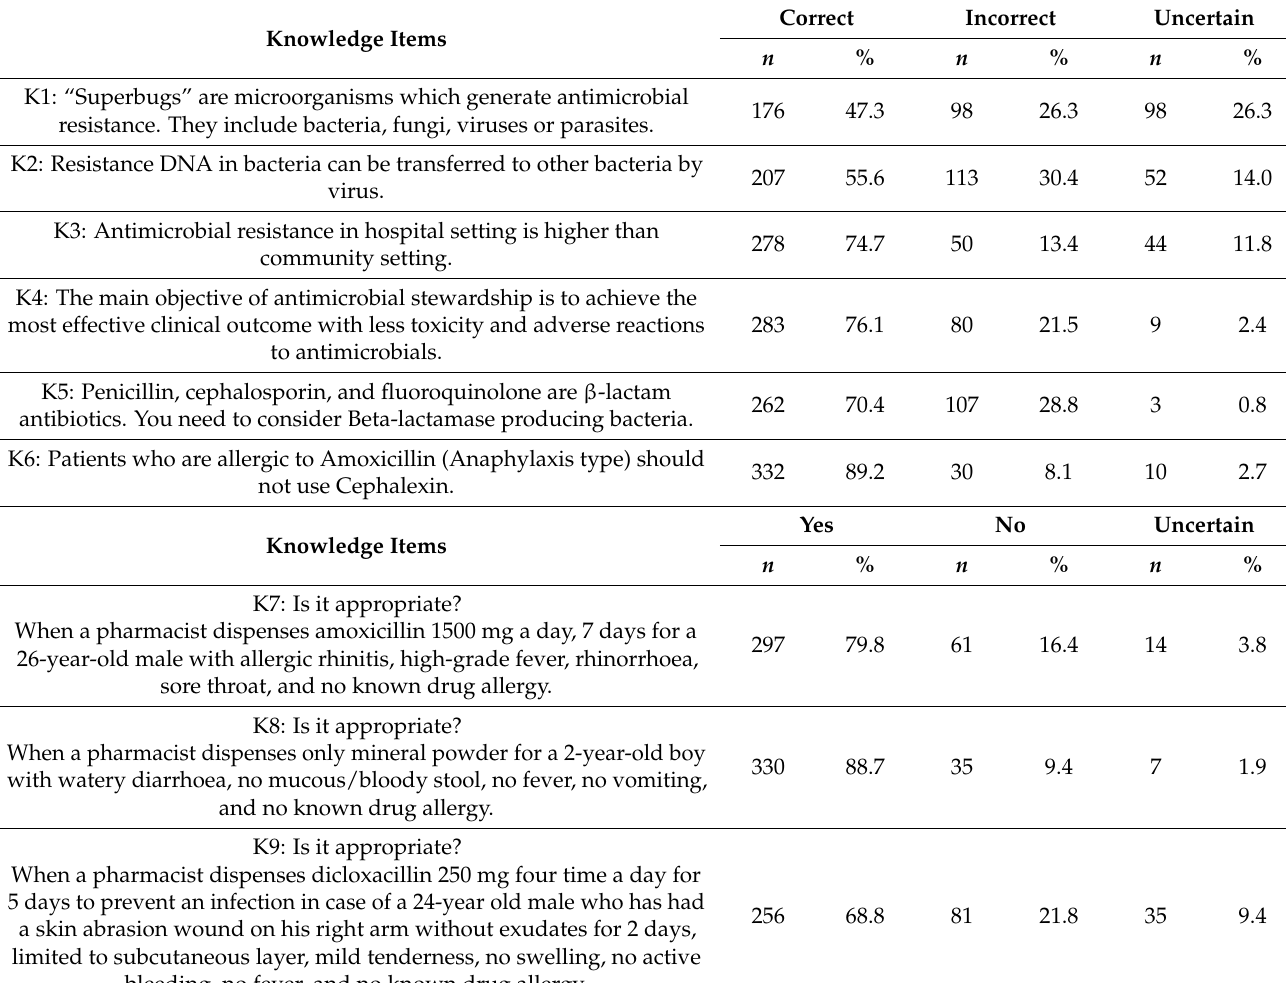
Table 2. Frequency of correct, incorrect, and uncertain answers for statements about knowledge of antimicrobials’ use and